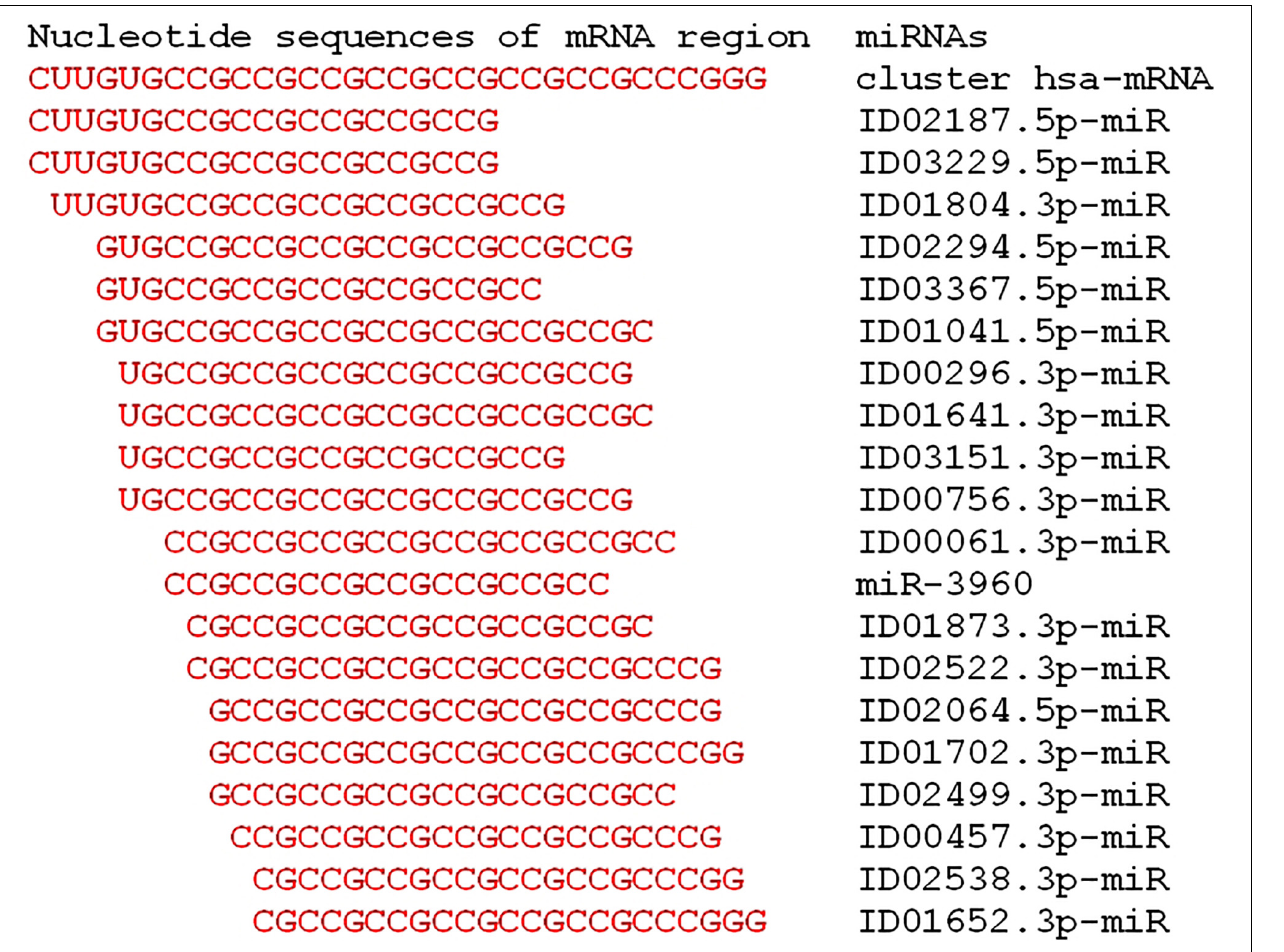
Frontiers in Genetics |